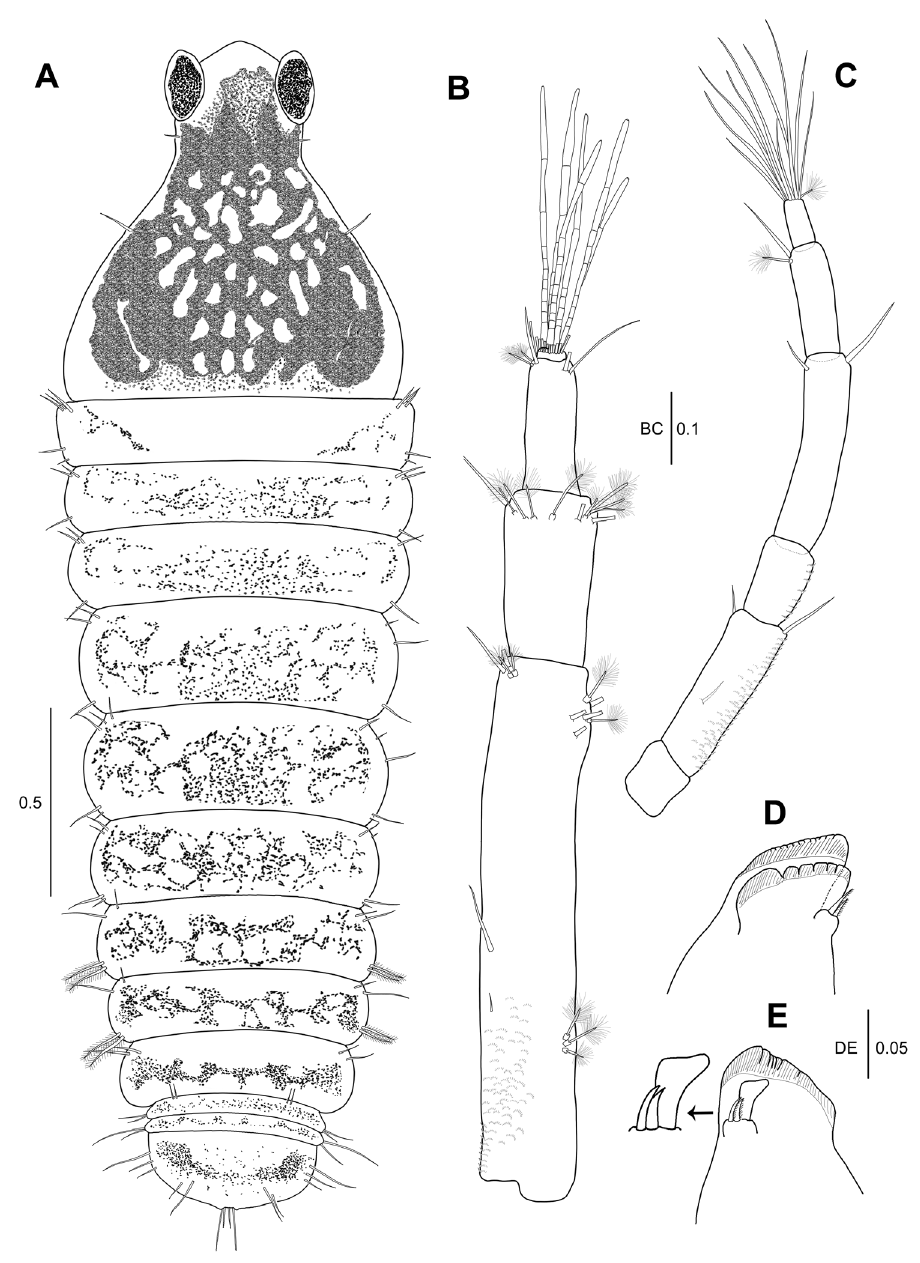
Figure 5. Hexapleomera ulsana sp. n., male allotype, A habitus, dorsal, all pigmentations except that on carapace not presented B antennule C antenna D left mandible, incisor, lacinia mobilis, and setal row E right mandible, incisor, lacinia mobilis, and setal row. Scale bars in